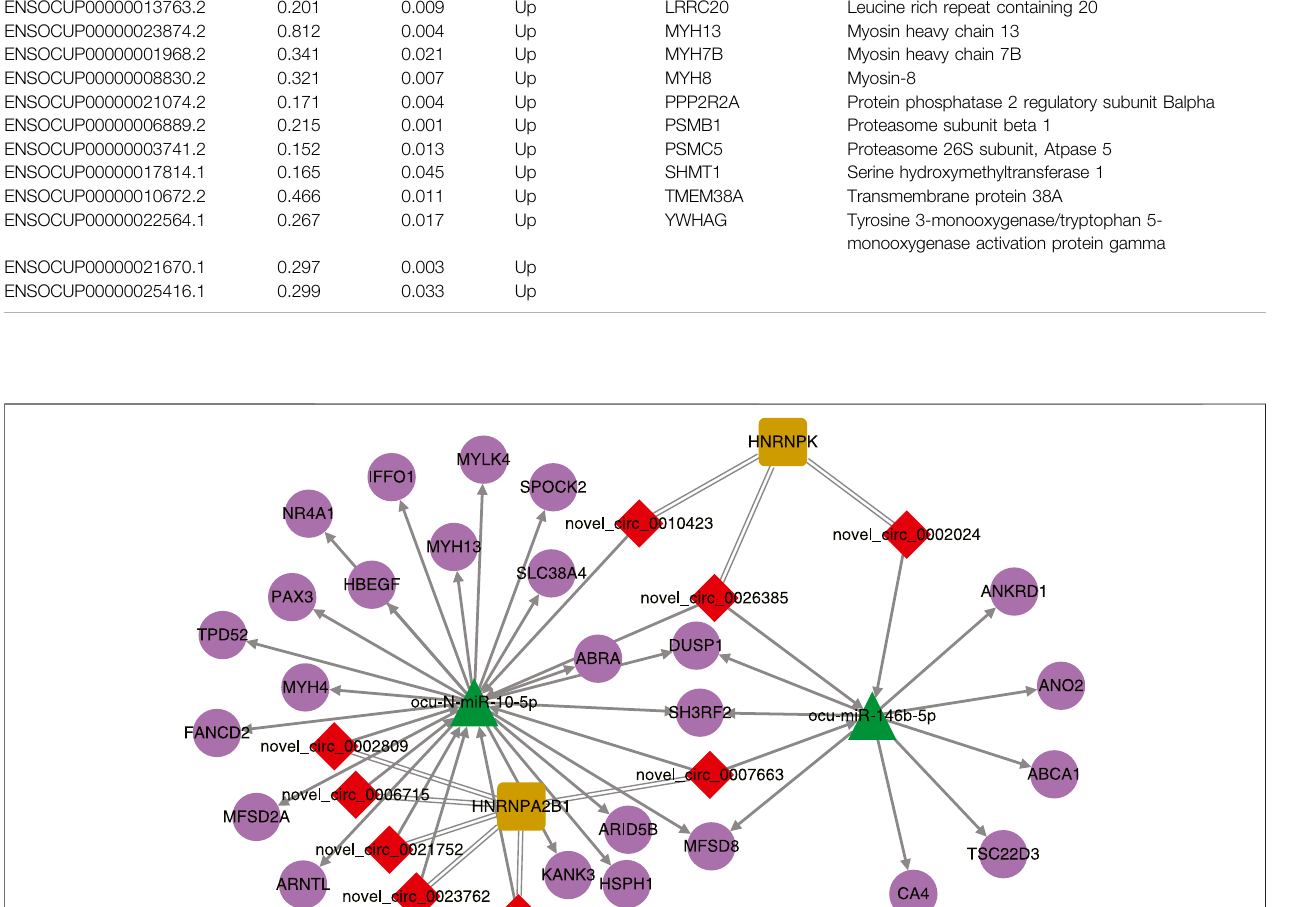
Frontiers in Genetics |